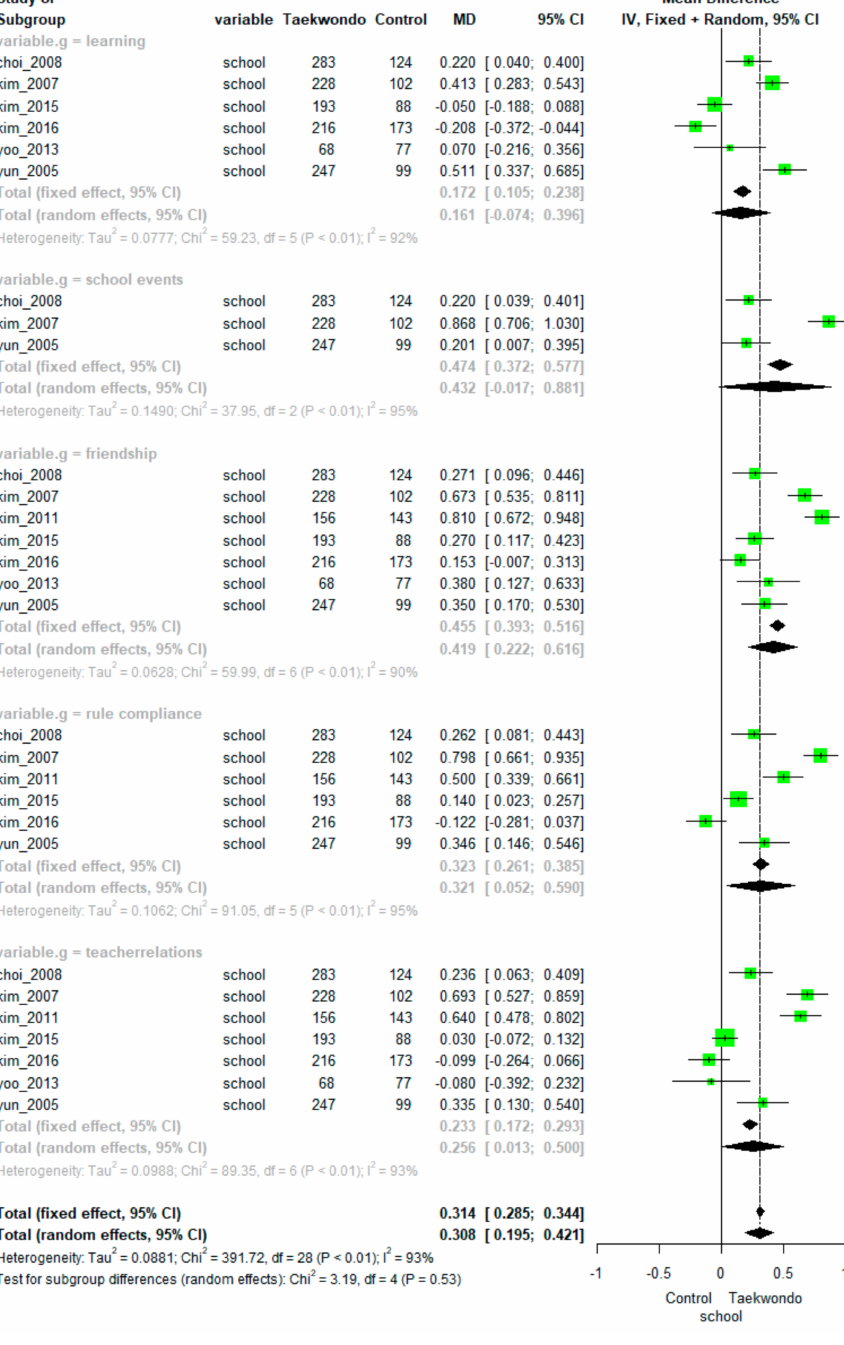
Figure 5. Forest plot of Taekwondo effects on school life